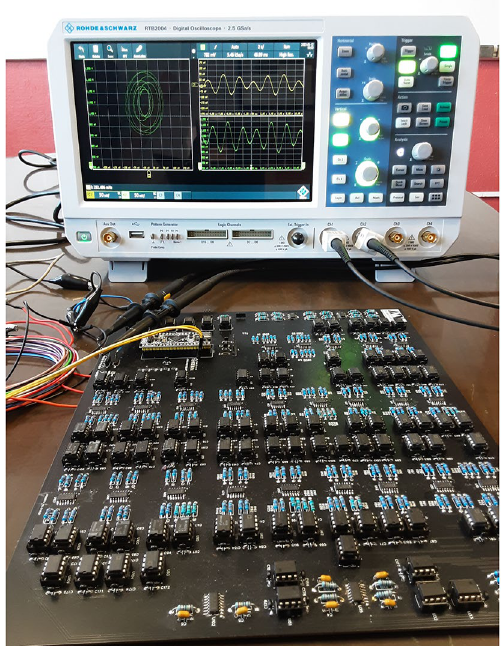
Figure 6. Experimental setup of the classical harmonic three-body